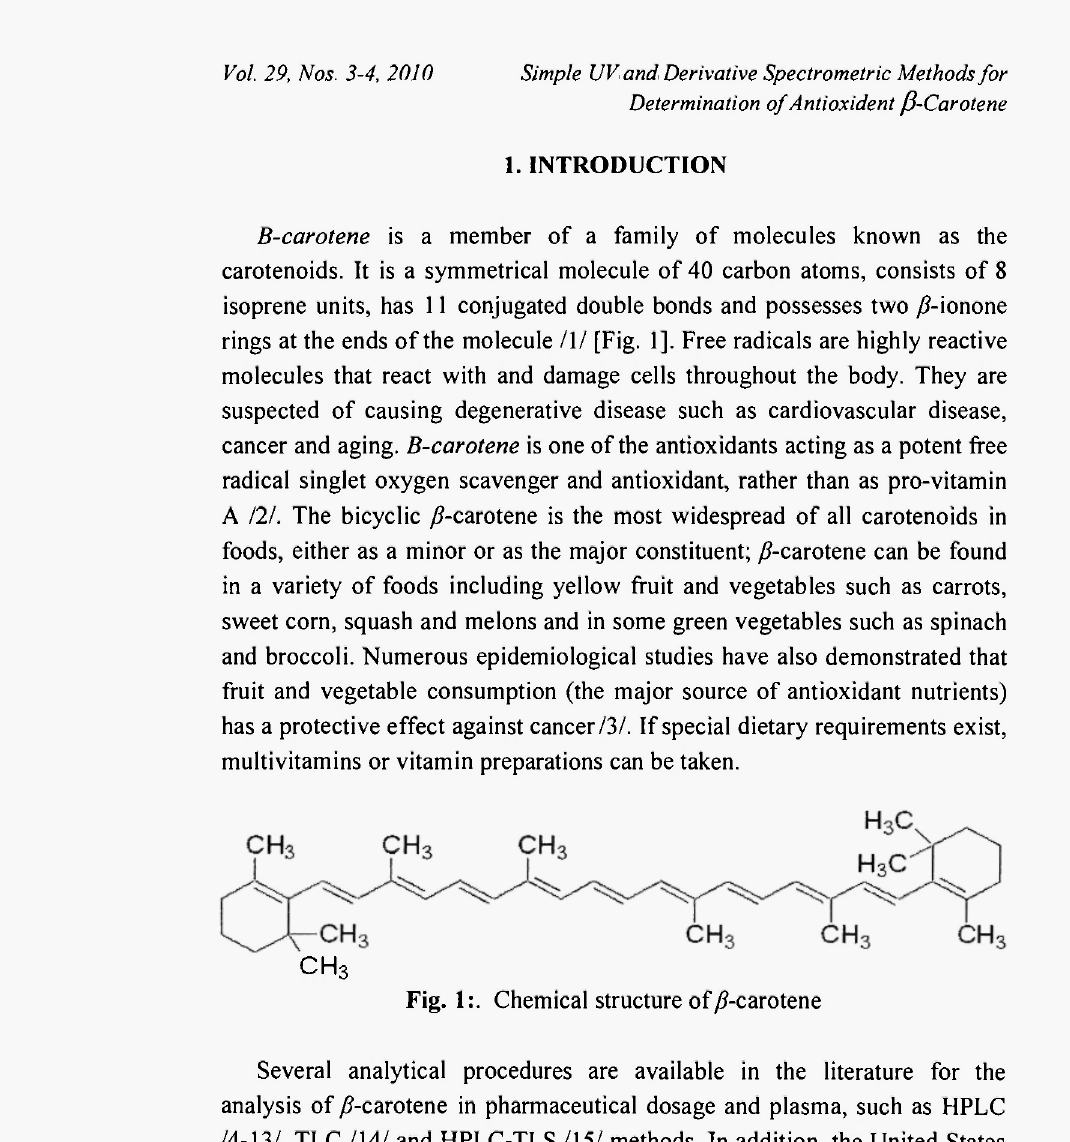
Fig. 1:. Chemical structure of